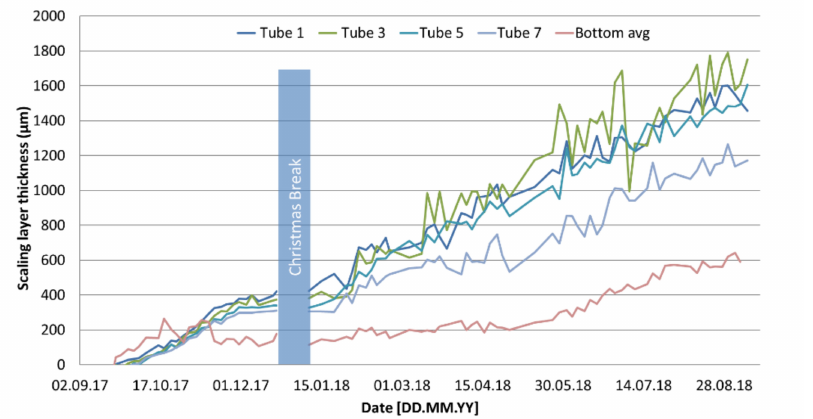
Figure 3. Thickness measurement at four tubes at the top and all bottom tubes (averaged) of the bundle.